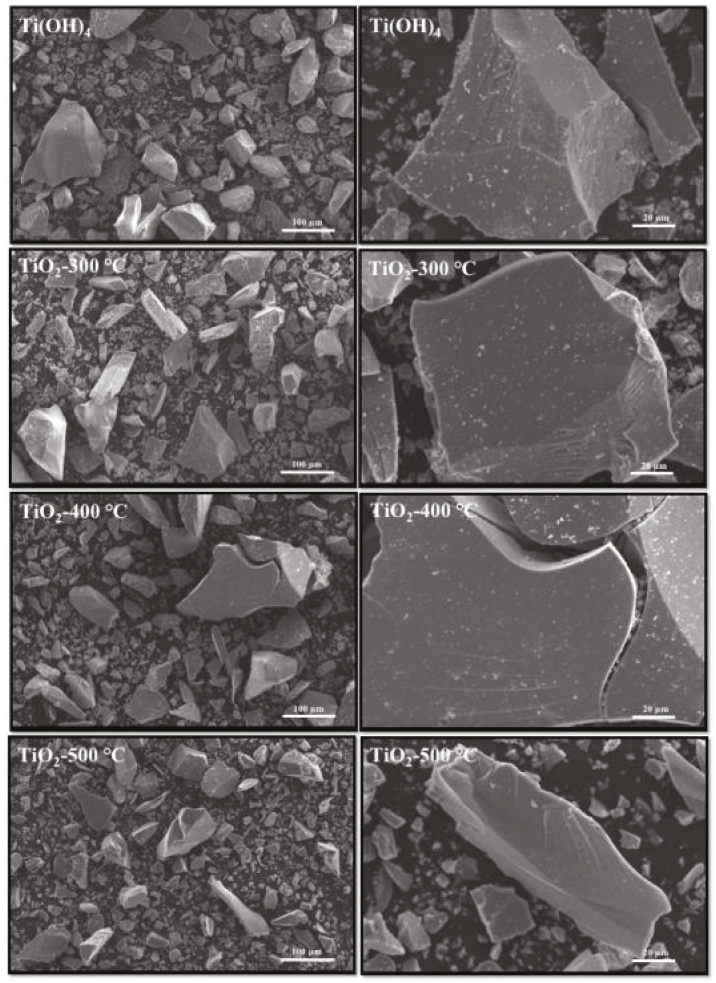
Figure 5: FEGSEM image of the Ti(OH)